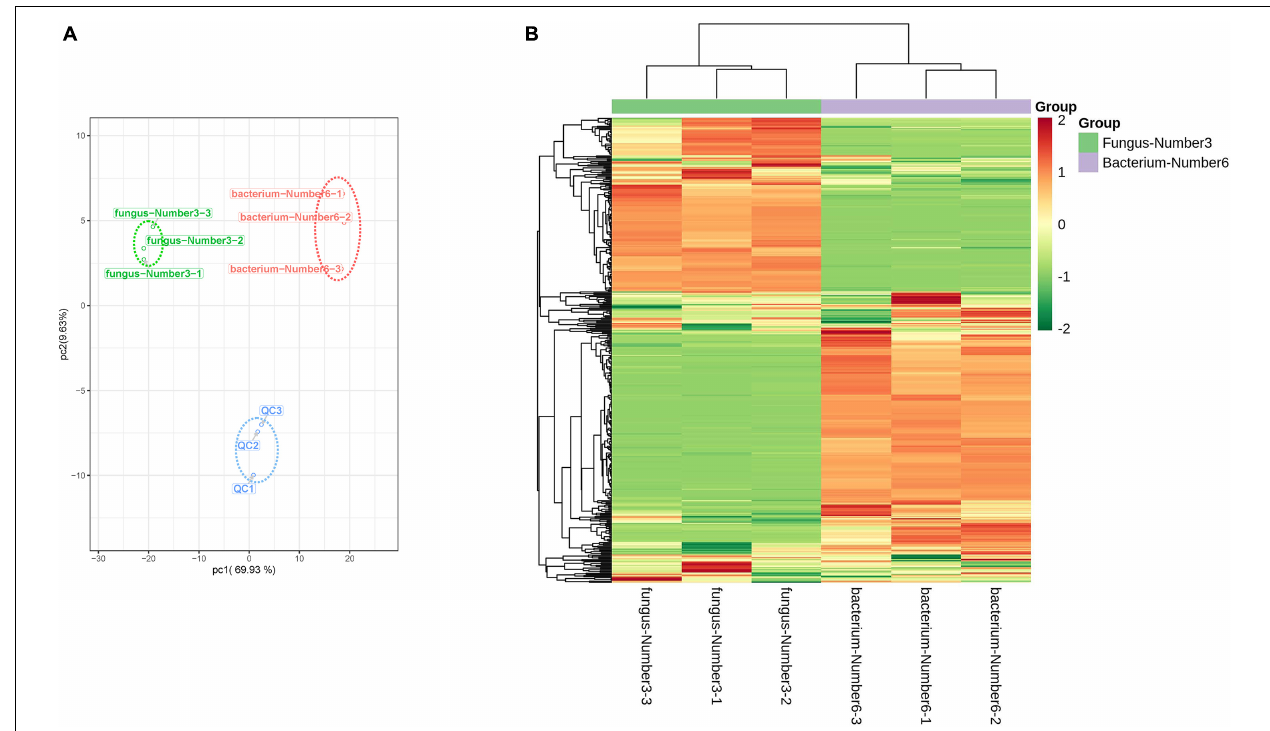
FIGURE 1 | Differences in the metabolites between Bacillus sp. and Aspergillus niger . (A) PCA analysis of the metabolites identified from f Aspergillus niger and Bacillus sp. Equal volumes of Aspergillus niger and Bacillus sp. samples were mixed for quality control (QC). (B) Cluster analysis of metabolites from samples of Aspergillus niger and Bacillus sp. The color indicates the level of accumulation of each metabolite from low (green) to high (red). The Z-score represents the deviation from the mean in standard deviation units.